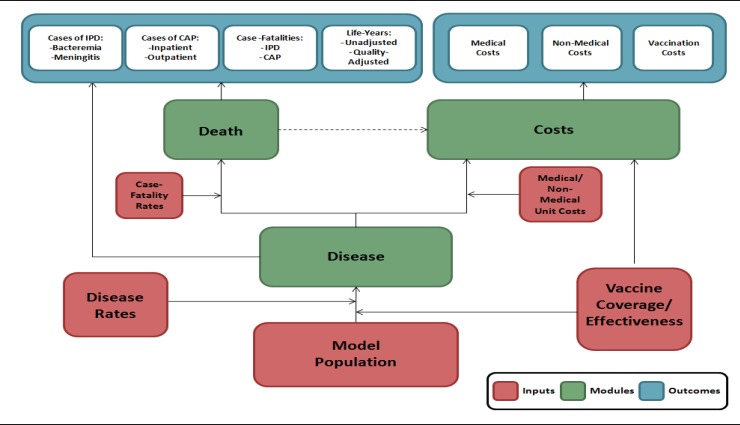
Model schematic.